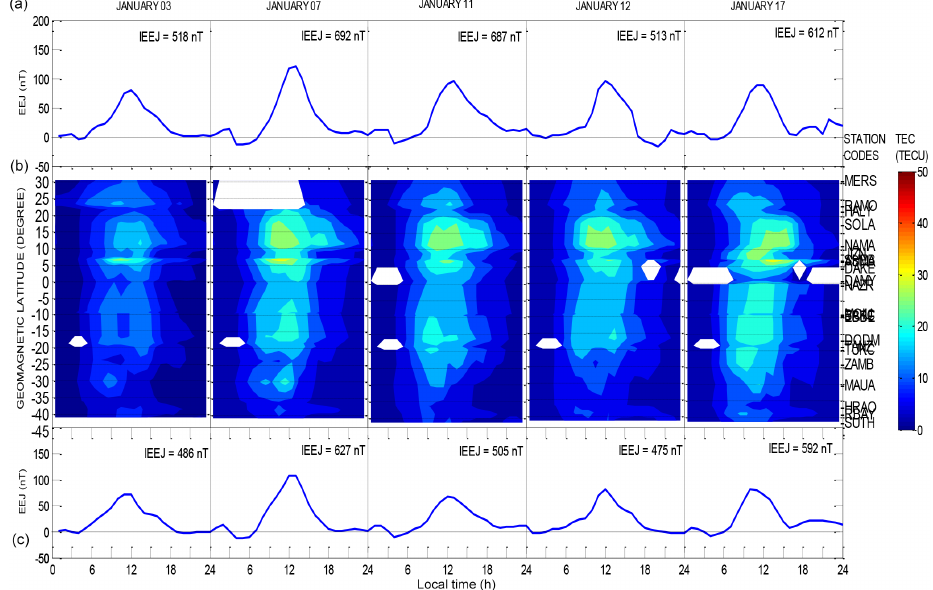
Figure 2. The TEC magnitudes of the quietest days, equatorial electrojet (EEJ) strength, and integrated EEJ strength in January.